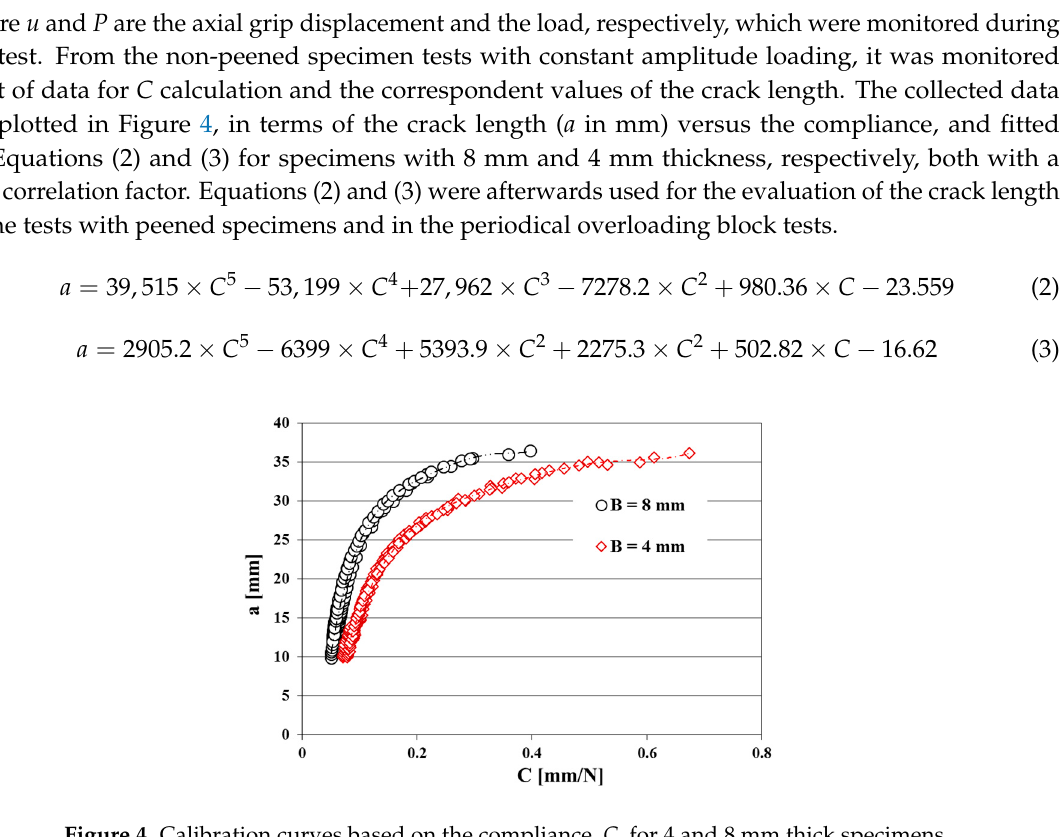
Figure 4. Calibration curves based on the compliance, C , for 4 and 8 mm thick specimens.